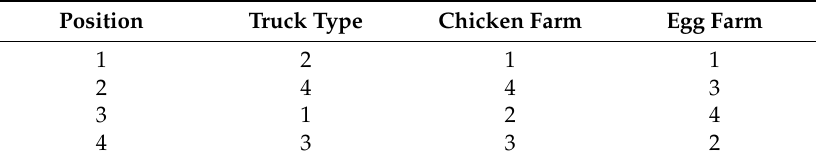
Table 7. Sequence of position in vectors of truck type, chicken farm, and egg